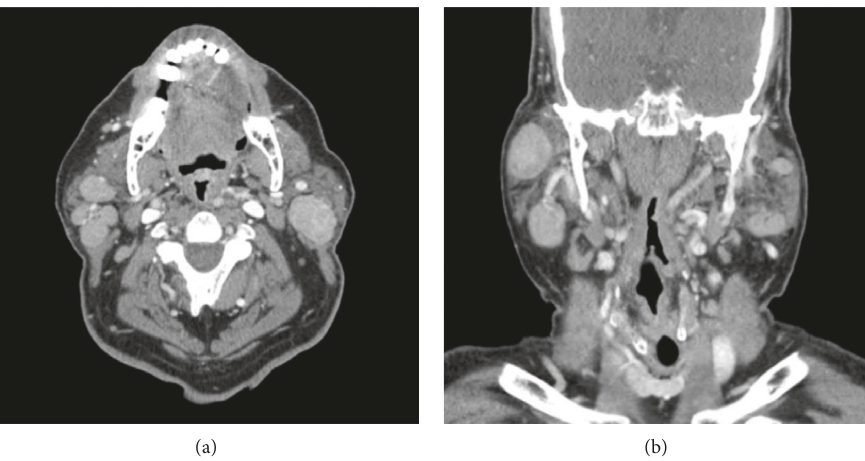
Figure 1: Computed tomography (CT) with contrast in axial and coronal planes showing bilateral parotid lesions and cervical right paratracheal node. Cytopathology revealed absence of malignant cells. Flow cytometry was negative for lymphoma.